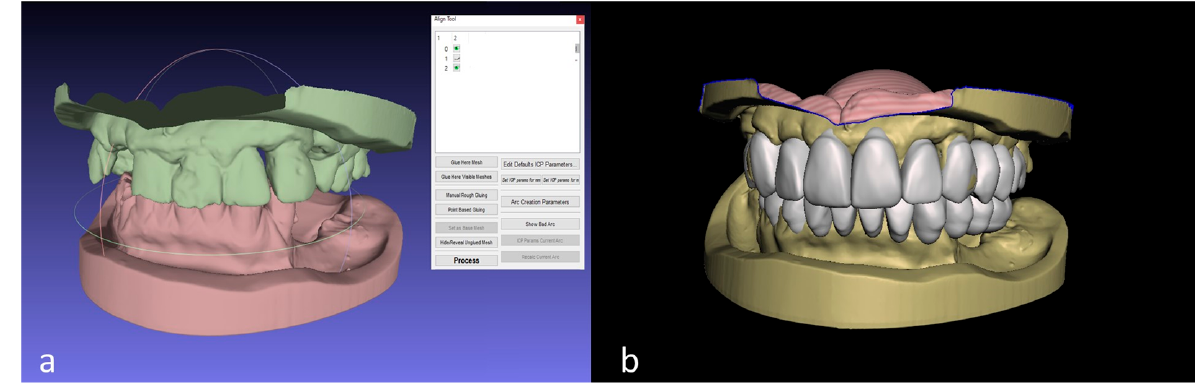
Figure 3. Digital maxillary and mandibular casts and digital tooth arrangements. ( a ) Digital casts are related in a centric relation at the desired vertical dimension of occlusion, determined intraorally using leaf gauge and bite registration material. Scans related to the bite scan using multiple surface points as references were created using the point-based gluing option in the STL editor software (MeshLab; STI-CNR) (name of the files removed for privacy reasons). ( b ) Digital tooth arrangements performed in open-source 3D modeling software (MeshMixer 3.3.; Autodesk Inc., San Rafael, CA, USA). The Christian Brenes Tooth library was imported into the modeling software and oriented using the transform tool; markings previously scribed in the buccal surface of the cast and extraoral photographs were used as references for the incisal edge position and establishing the occlusal plane.